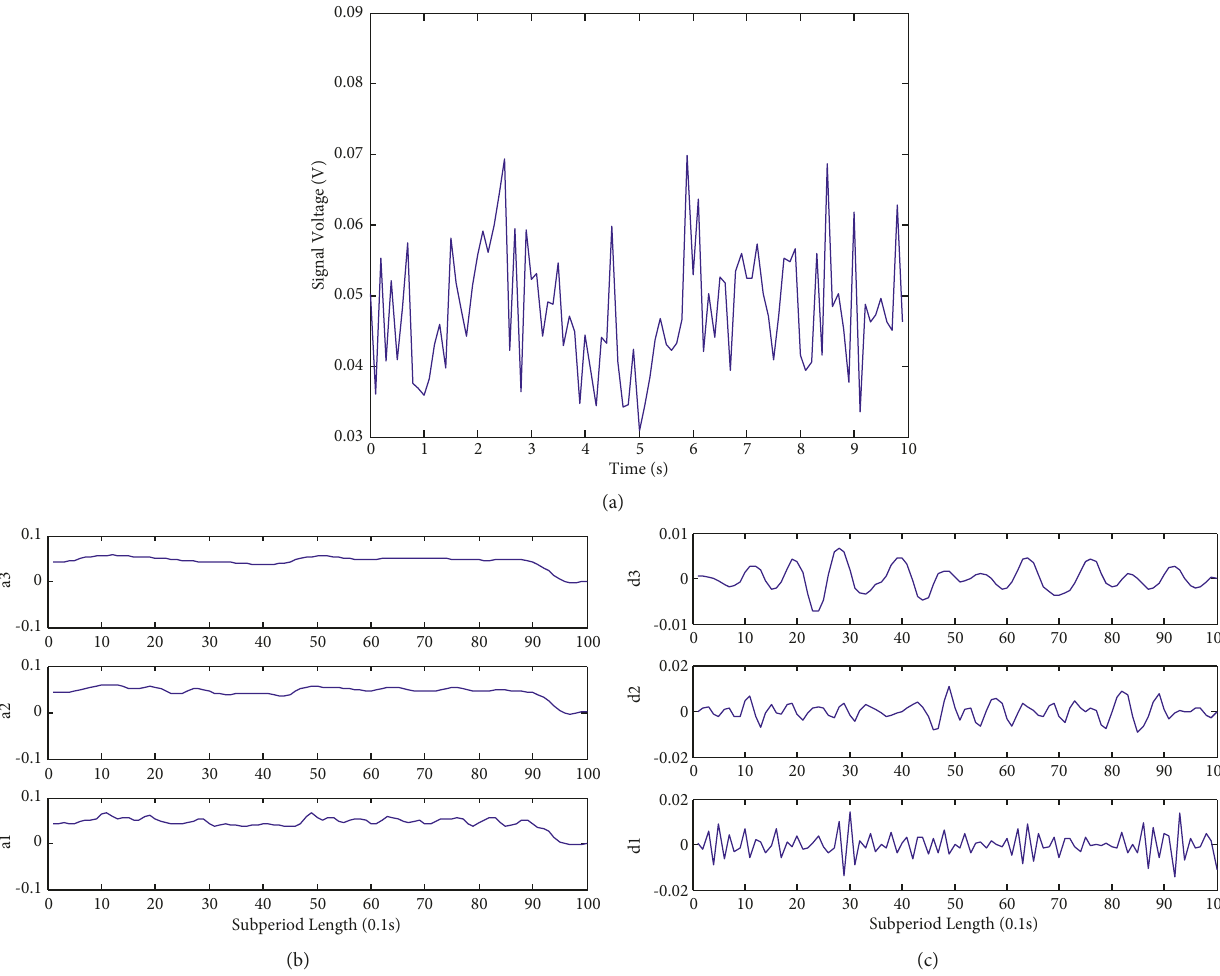
Figure 4: (a) FFT signal with solid to air mass ratio 0.6 and gas flow of 160m 3 /h; (b) wavelet transform approximation signal; (c) wavelet transform detail